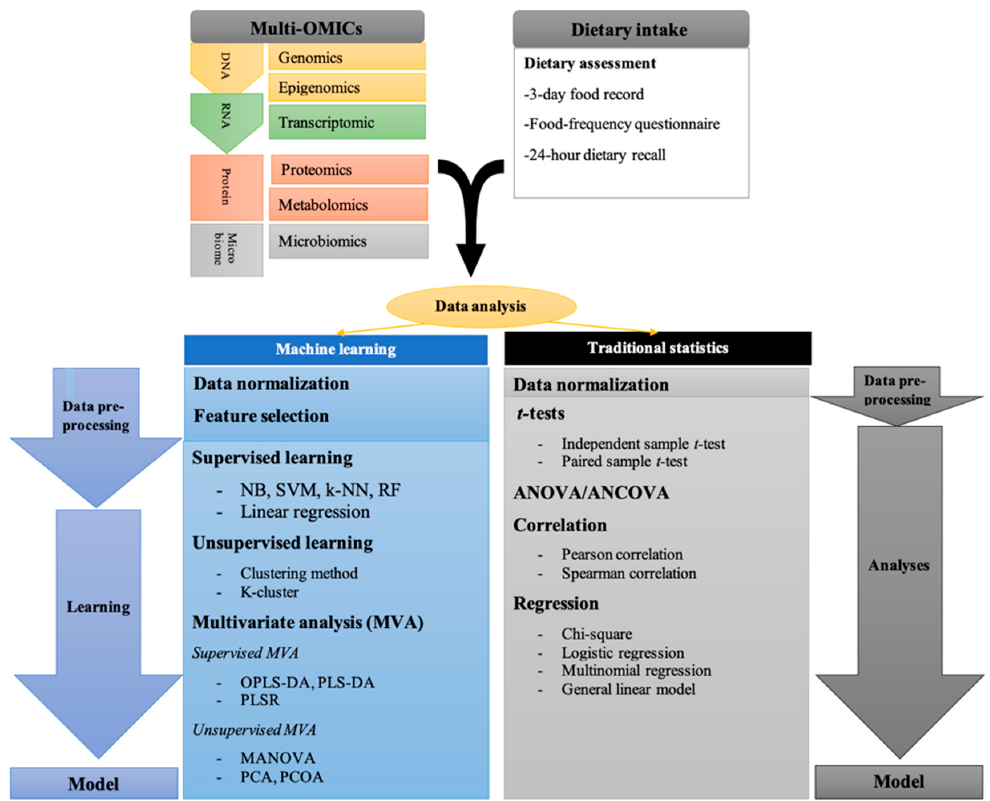
Figure 1. Traditional statistical, and machine analysis (supervised, unsupervised machine learning and multivariate analysis) were used in nutri-OMICs studies. Analysis of variance, ANOVA; k-nearest neighbor’s algorithm, k-NN; Support vector machine, SVM; Regression random forest, RF; Naïve ayes, NB; Partial least-squares regression, PLSR; Orthogonal projections to latent structures discriminant analysis, OPLS-DA; Partial least squares discriminant analysis, PLS-DA; Principle component analysis, PCA; Principal coordinate analysis, PCoA; Multivariate analysis of variance, MANOVA.